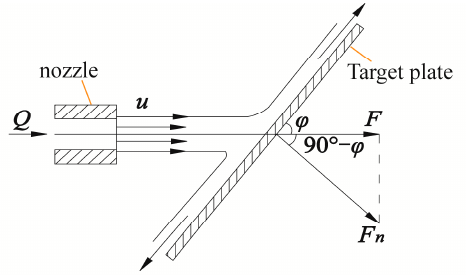
Figure 7. The force analysis model of the high-pressure water jet impact on the target plate.